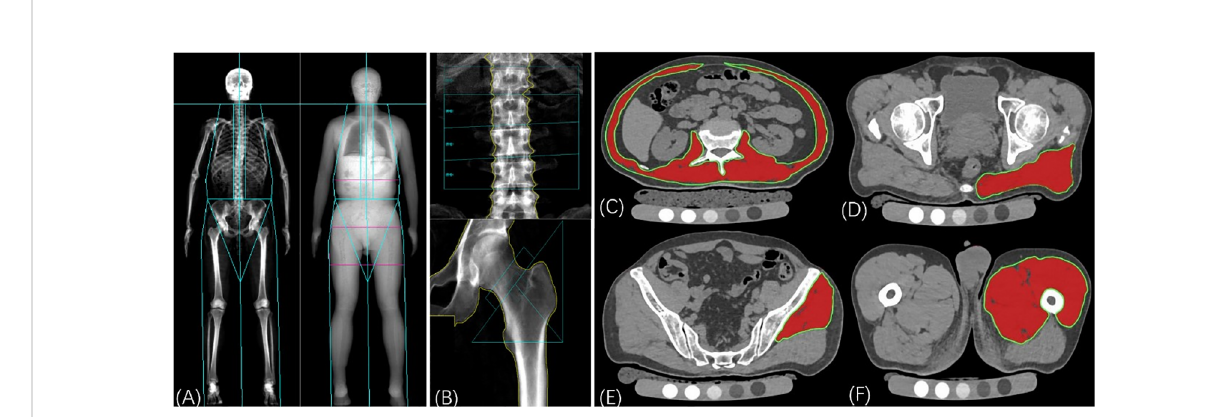
FIGURE 3 Dual-energy X-ray absorptiometry (DXA) and computed tomography (CT) assessments. (A) : the whole body DXA scan for body composition analysis, mainly for the evaluation of muscle and fat mass. (B) : Areal BMD was calculated by the DXA scan of the lumbar spine and left hip. (C) ~ (F) : Muscle assessments with QCT including muscle density, muscle area, and intermuscular fat area. (C) : Measurement of trunk muscle at mid- L2 level; (D) : Measurement of cross-sectional area and mean computed tomography values of the gluteus maximus muscle at the level of the greater trochanter of the femur; (E) : Measurement of the gluteus medius and minimus muscle at the third sacral level; (F) : Measurement of the middle thigh muscle level. The muscle region is represented by the area highlighted in red. The area of intramuscular fat in fi ltration is obtained by subtracting the area of red ROI from the area of green ROI with the threshold segmentation